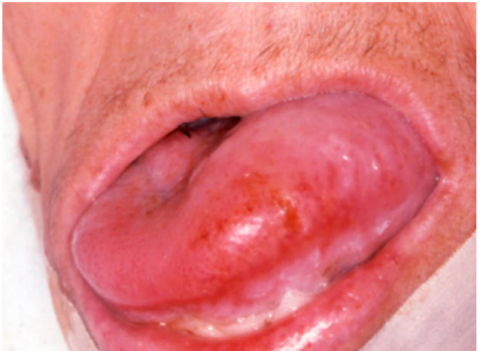
Figure 5. Macroglossia related to a nodular enlargement as first sign of Primary